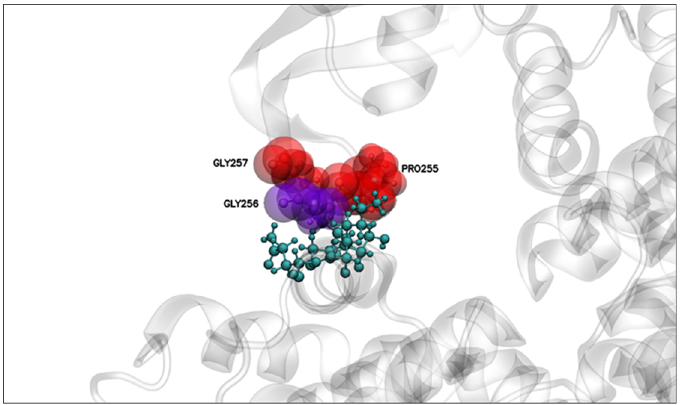
Figure 7. PS2Aa1–APN interaction. Relevant residues for interaction with APN are analyzed in Figure 6. Distances were computed between the center of mass of the relevant residues of PS2Aa1 and the closest residue from